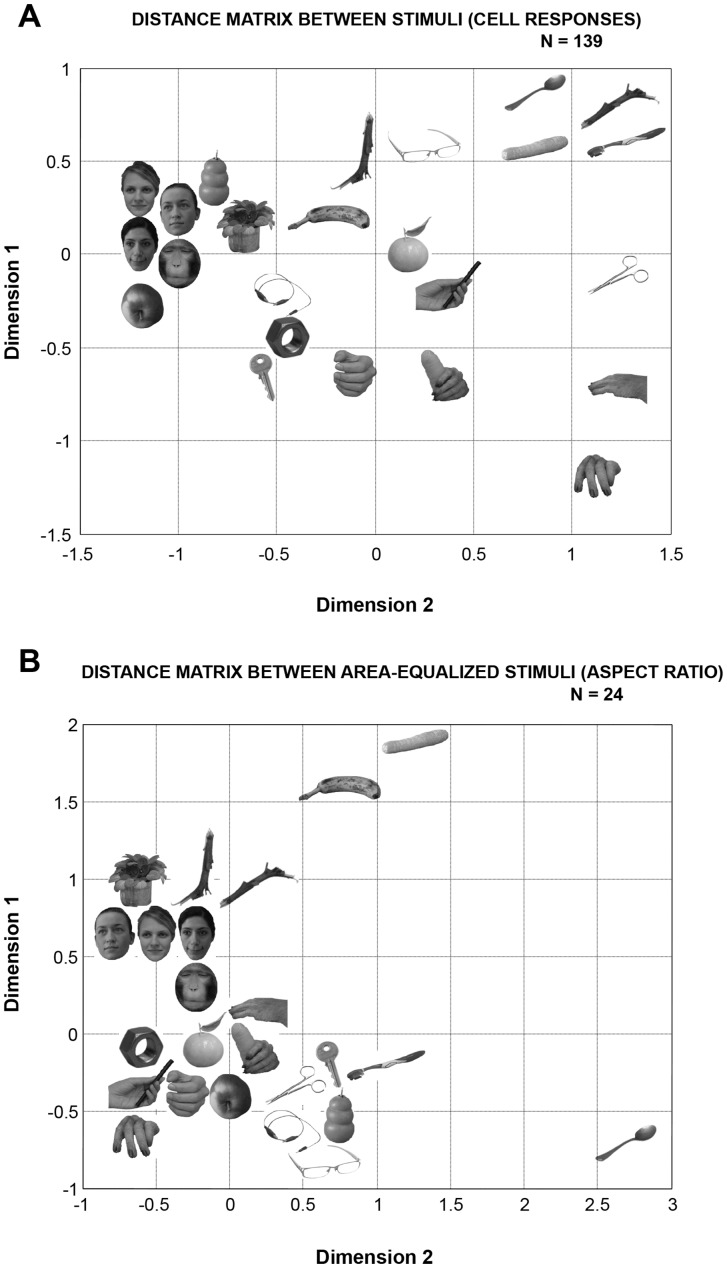
Multi-dimensional scaling (MDS) analysis.(A). Two-dimensional MDS solution using the pair-wise correlations between the images based on the net AIP responses as estimates of the inter-stimulus distances. (B). Two-dimensional MDS solution using the aspect ratio of the images (largest diameter divided by the smallest diameter).